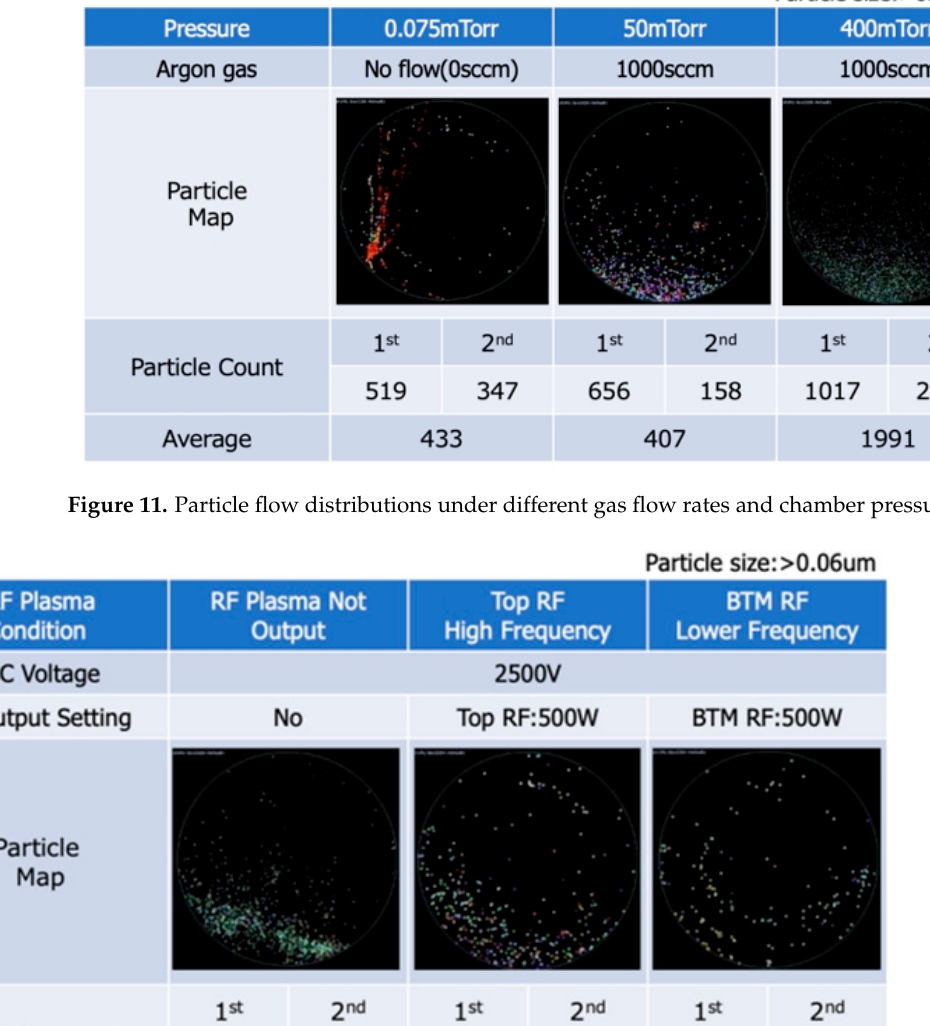
Figure 11. Particle flow distributions under different gas flow rates and chamber pressures.